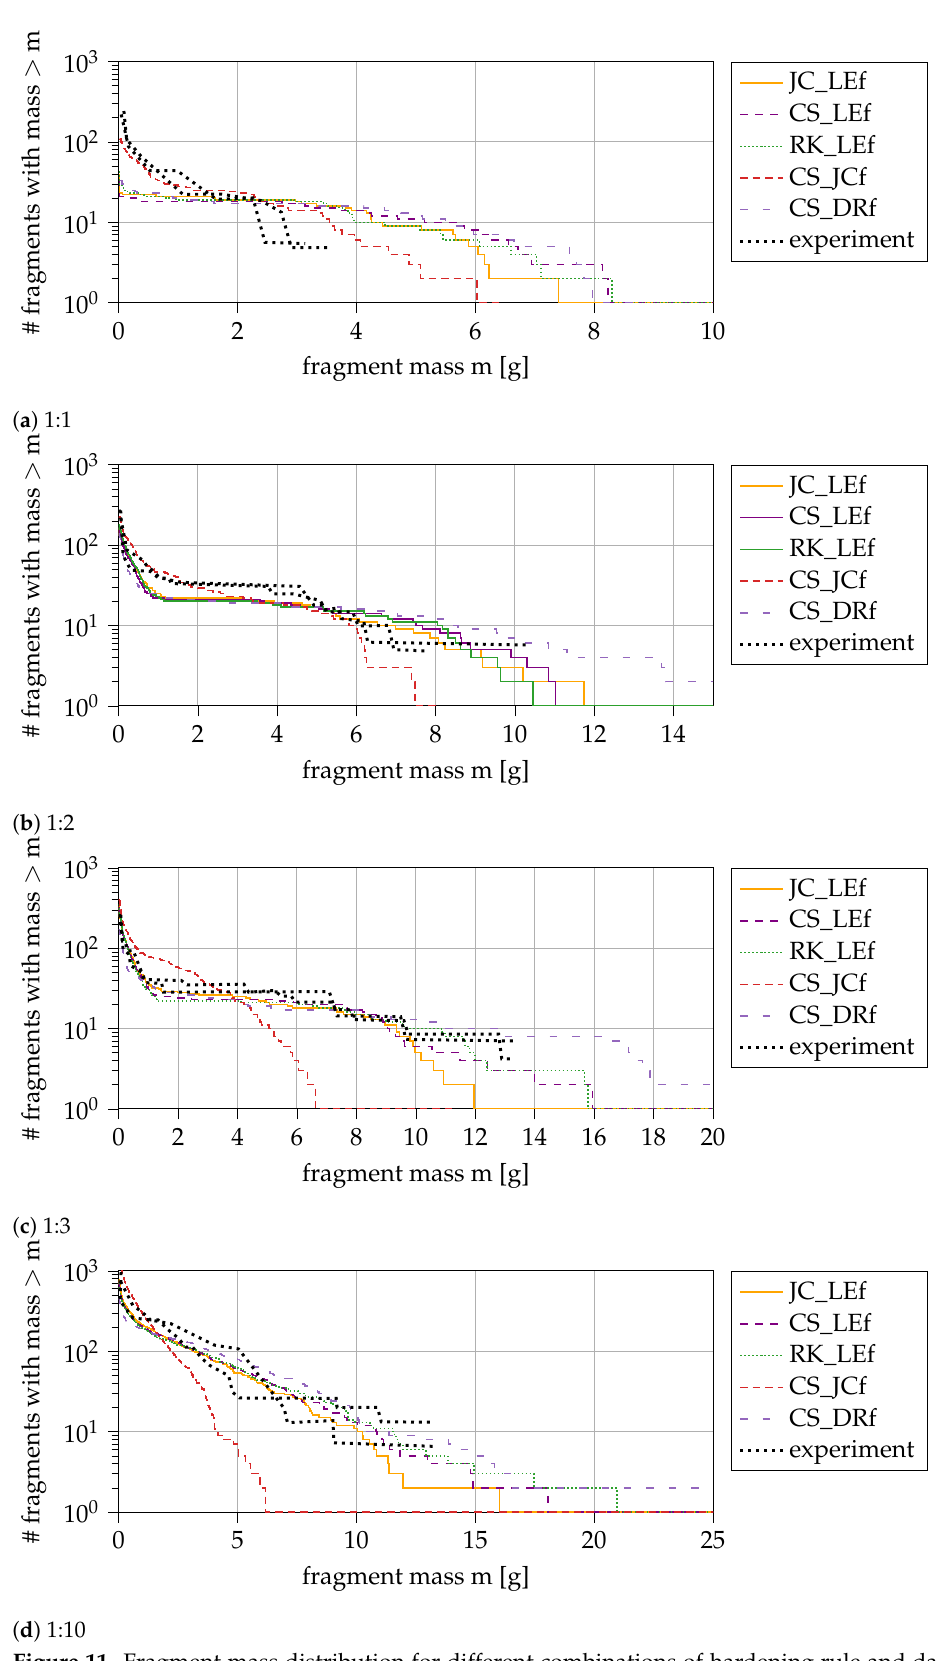
Figure 11. Fragment mass distribution for different combinations of hardening rule and damage model: JC_LEf = JC hardening + LEf damage, CS_JCf = CS hardening + JCf damage, CS_LEf = CS hardening + LEf damage, CS_DRf = CS hardening + DRf damage, RK_LEf = RK hardening + LEf damage; experiment from